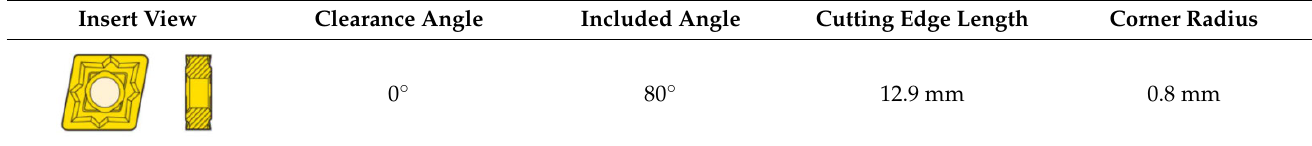
Figure 2. Experimental setup of the turning experiment: ( a ) machine tool, workpiece, and tool assembly, and ( b ) force measurement system. Table 2. Geometry of the cutting insert used in this study.